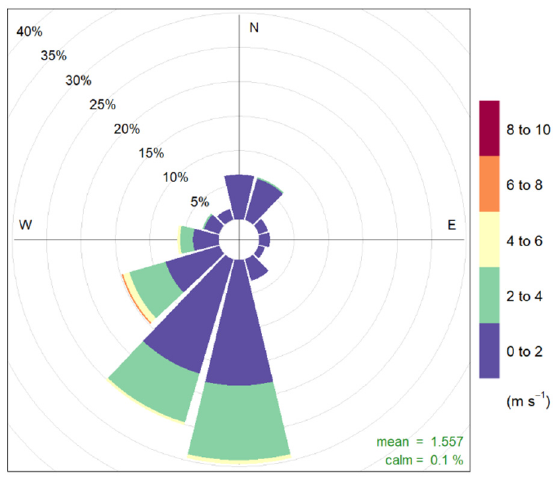
Figure 1. Wind rose from Strasbourg data over the measurement period.